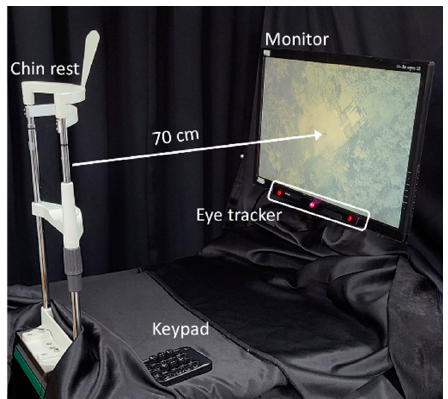
Figure 2. A photo of the experimental setup.